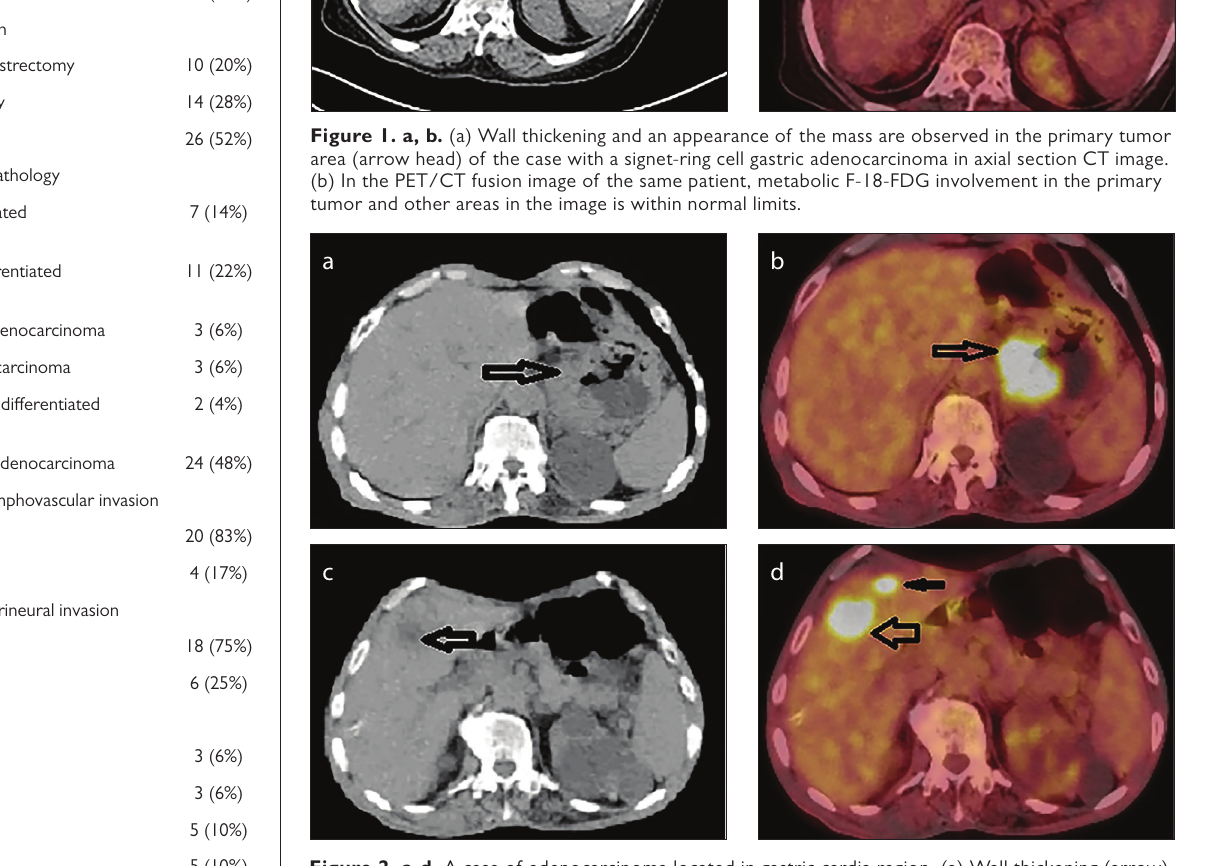
Figure 2. a-d. A case of adenocarcinoma located in gastric cardia region. (a) Wall thickening (arrow) is observed in axial section CT image. (b) Hypermetabolic FDG involvement (arrow) is observed in primary tumor (SUVmax: 12.29) in an axial section PET/CT fusion image. (c) Tumor metastasis in liver is observed as hypodense area (arrow) in an axial section CT image. (d) Axial PET/CT fusion